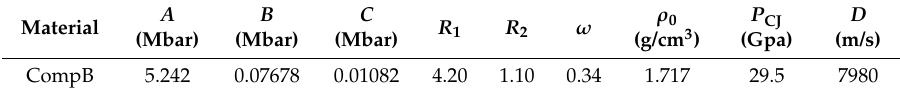
Table 4. The JWL parameters and C-J parameters of the compB explosive.